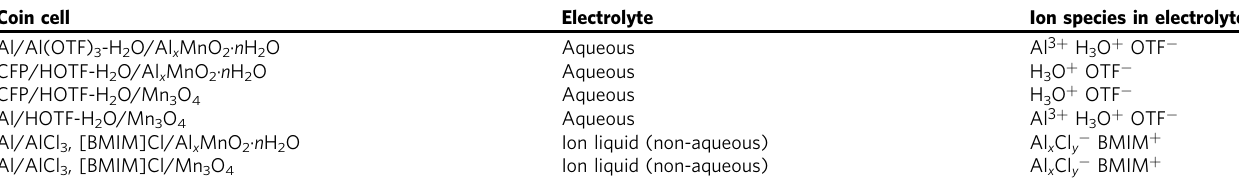
Table 1 The ion species and solvent molecular contained in the electrolyte of comparative samples Coin cell